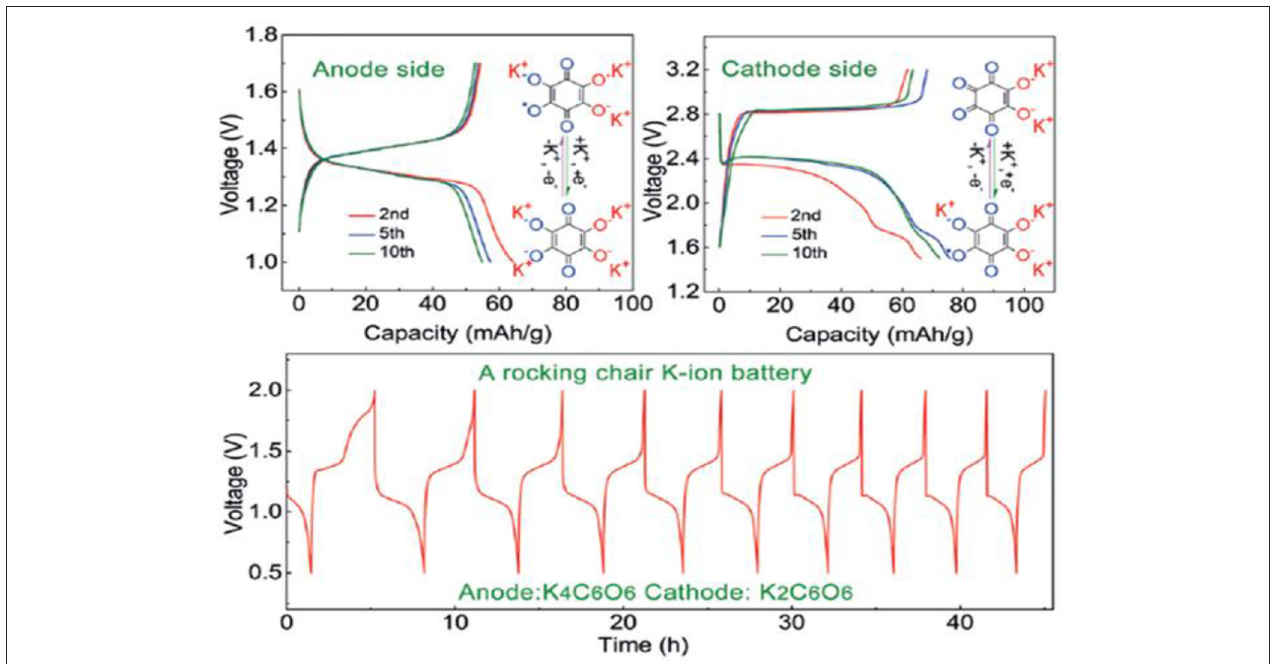
FIGURE 9 | Example of full organic KIB cycled at the current density of 25 mAh/g with oxocarbons K 4 C 6 O 6 and K 2 C 6 O 6 as negative and positive electrodes, respectively. Reprinted with permission from Zhao Q. et al. (2016). Copyright (2016) WILEY-VCH Verlag GmbH & Co. KGaA, Weinheim.